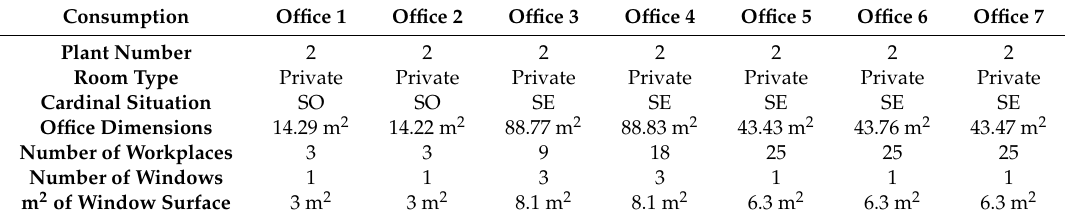
Table 2. Total consumption in kWh during the 30 days of baseline data collection, during the 30 days of the experiment, difference in the consumption and savings between the two